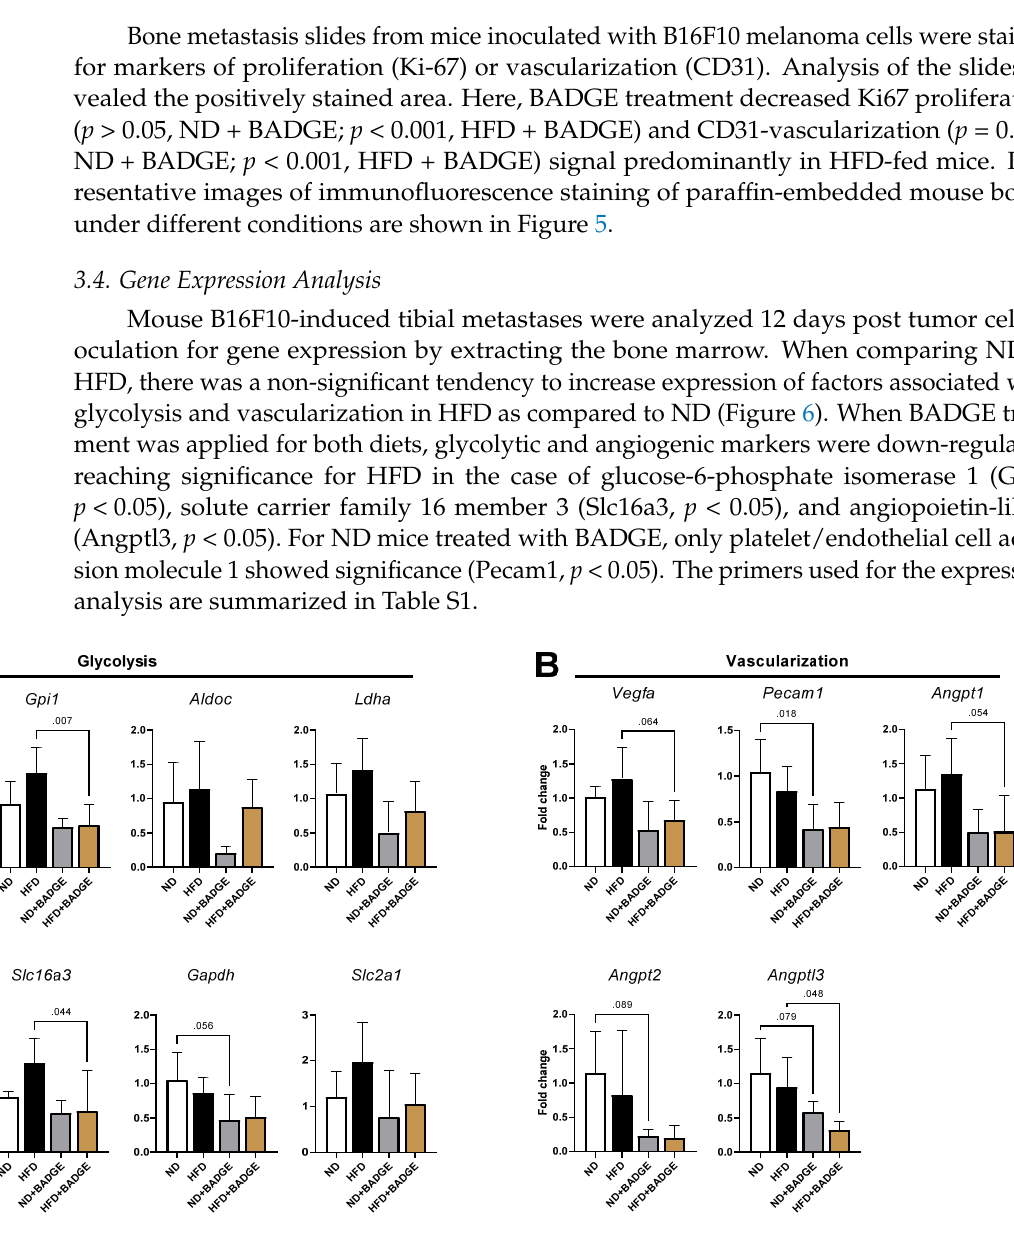
Figure 6. Antagonism of PPAR γ in tumor-bearing mice decreased glycolytic and vascularization markers. ( A ) Gene expression markers for glycolysis. ( B ) Gene expression markers for vascularization. Relative gene expression in normally fed tumor-bearing mouse bone marrow normalized to ND with tumors. Values of p indicated up to a value of 0.15 (only decimal places given).